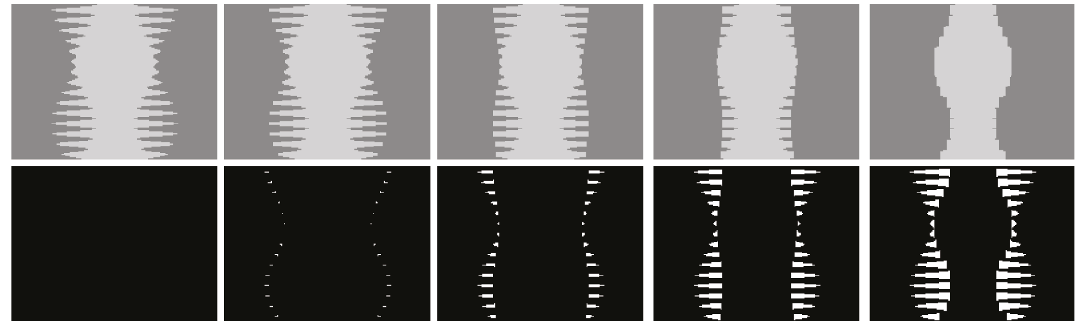
Figure 12: Succession of openings with vertical structuring elements and the corresponding di ff erences (between the original image and the